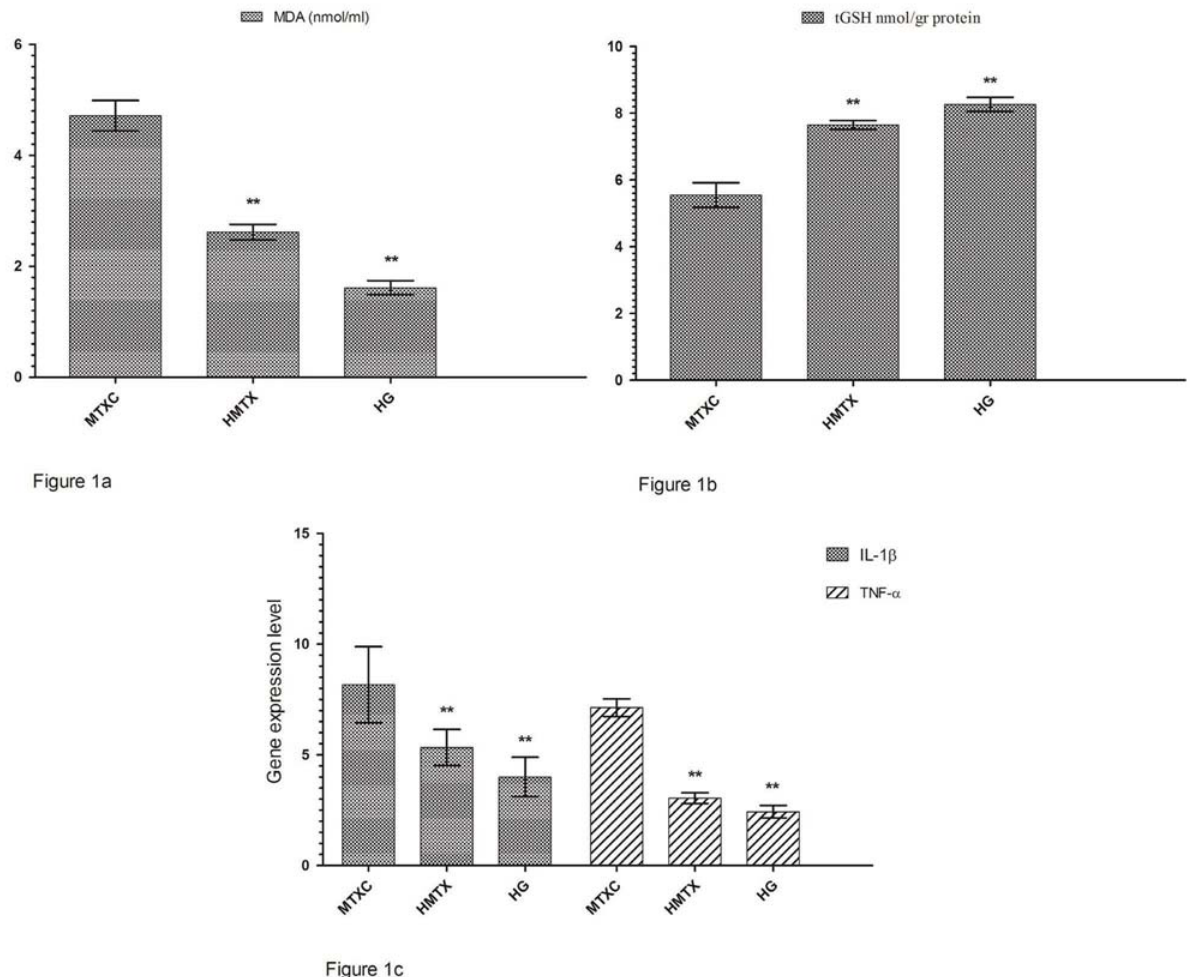
Figure 1- a: The effects of methotrexate on malondialdehyde (MDA) levels in the cheek mucosal tissues; b: The effects of (cid:80)(cid:72)(cid:87)(cid:75)(cid:82)(cid:87)(cid:85)(cid:72)(cid:91)(cid:68)(cid:87)(cid:72)(cid:3)(cid:82)(cid:81)(cid:3)(cid:87)(cid:42)(cid:54)(cid:43)(cid:3)(cid:79)(cid:72)(cid:89)(cid:72)(cid:79)(cid:86)(cid:3)(cid:76)(cid:81)(cid:3)(cid:87)(cid:75)(cid:72)(cid:3)(cid:70)(cid:75)(cid:72)(cid:72)(cid:78)(cid:3)(cid:80)(cid:88)(cid:70)(cid:82)(cid:86)(cid:68)(cid:79)(cid:3)(cid:87)(cid:76)(cid:86)(cid:86)(cid:88)(cid:72)(cid:86)(cid:30)(cid:3)(cid:70)(cid:29)(cid:3)(cid:55)(cid:75)(cid:72)(cid:3)(cid:72)(cid:73)(cid:73)(cid:72)(cid:70)(cid:87)(cid:86)(cid:3)(cid:82)(cid:73)(cid:3)(cid:80)(cid:72)(cid:87)(cid:75)(cid:82)(cid:87)(cid:85)(cid:72)(cid:91)(cid:68)(cid:87)(cid:72)(cid:3)(cid:82)(cid:81)(cid:3)(cid:44)(cid:47)(cid:16)(cid:20)(cid:533)(cid:3)(cid:74)(cid:72)(cid:81)(cid:72)(cid:3)(cid:72)(cid:91)(cid:83)(cid:85)(cid:72)(cid:86)(cid:86)(cid:76)(cid:82)(cid:81)(cid:3)(cid:79)(cid:72)(cid:89)(cid:72)(cid:79)(cid:3) in the cheek mucosal tissues.